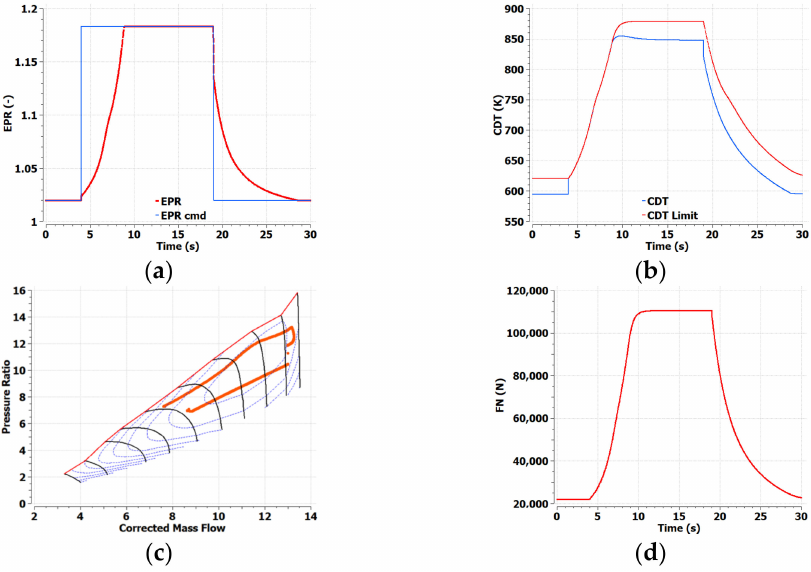
Figure 12. Square cycle simulation results: ( a ) EPR and command; ( b ) CDT and limit; ( c ) operating line on HPC map; ( d ) net thrust